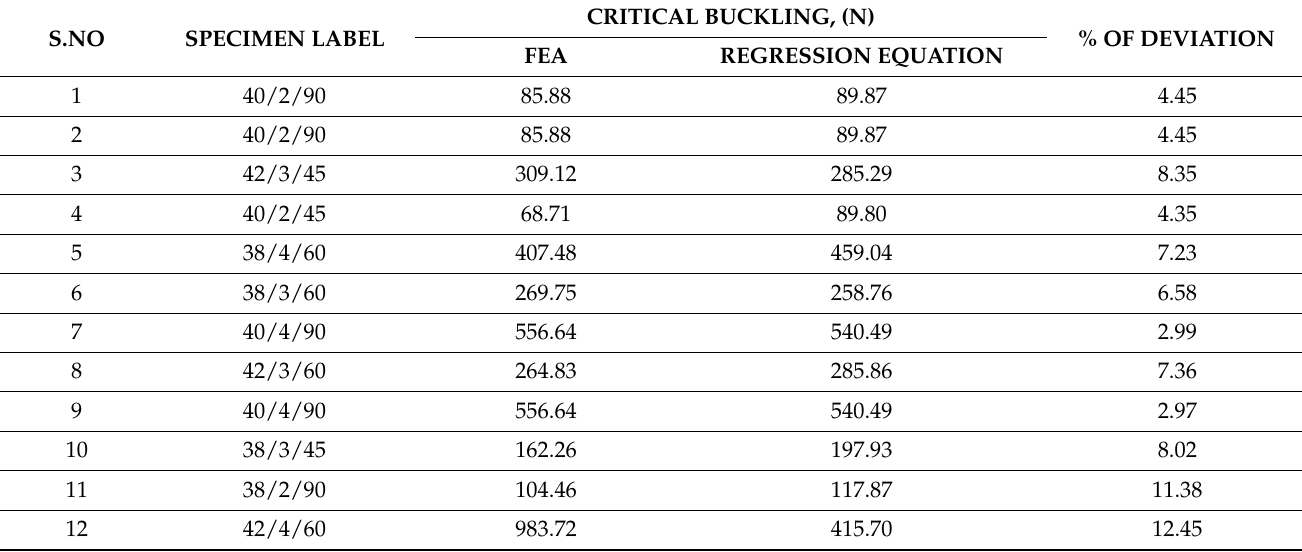
Table 9. Comparison of the critical buckling load of the finite element analysis model (FEA) and the regression equation.